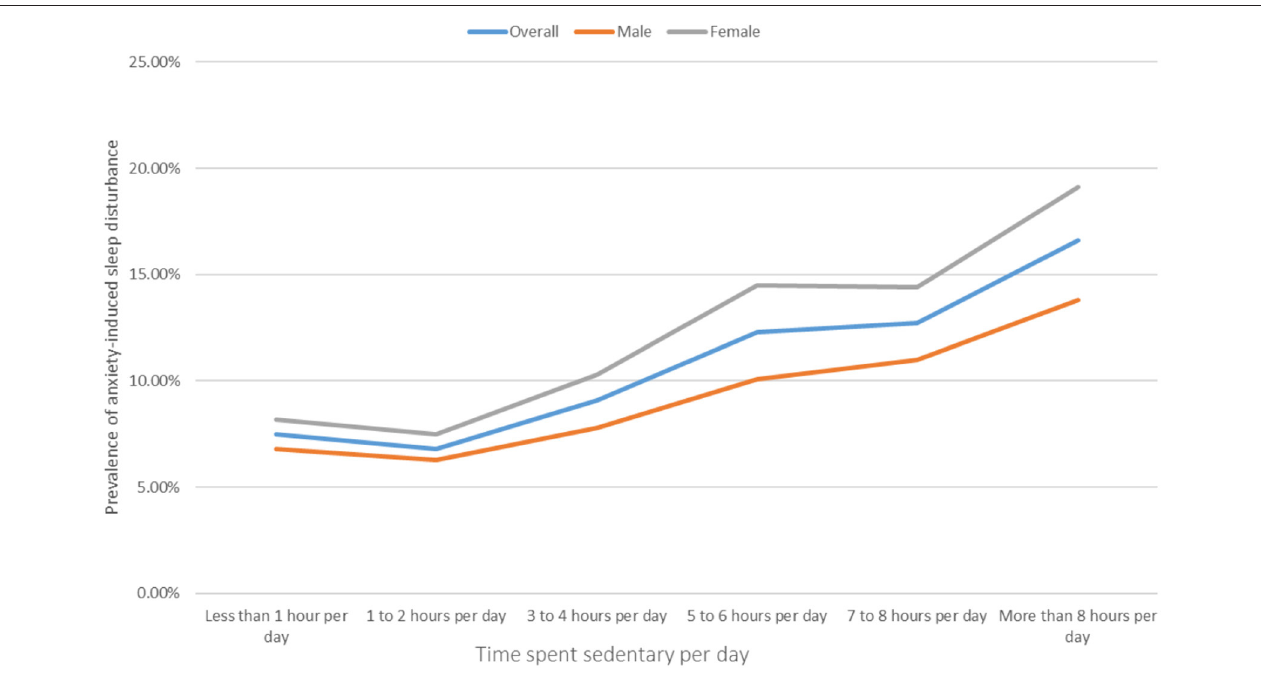
FIGURE 1 | Prevalence of anxiety-induced sleep disturbance by the time spent sedentary. The time spent sedentary per day was defined as answering “ < 1h per day,” “1–2h per day,” “3–4h per day,” “5–6h per day,” “7–8h per day,” or “ > 8h per day” to the question “Time spent sitting on usual day?.” Anxiety-induced sleep disturbance was defined as answering “most of the time” or “always” to the question “During the past 12 months, how often have you been so worried about something that you could not sleep at night?”